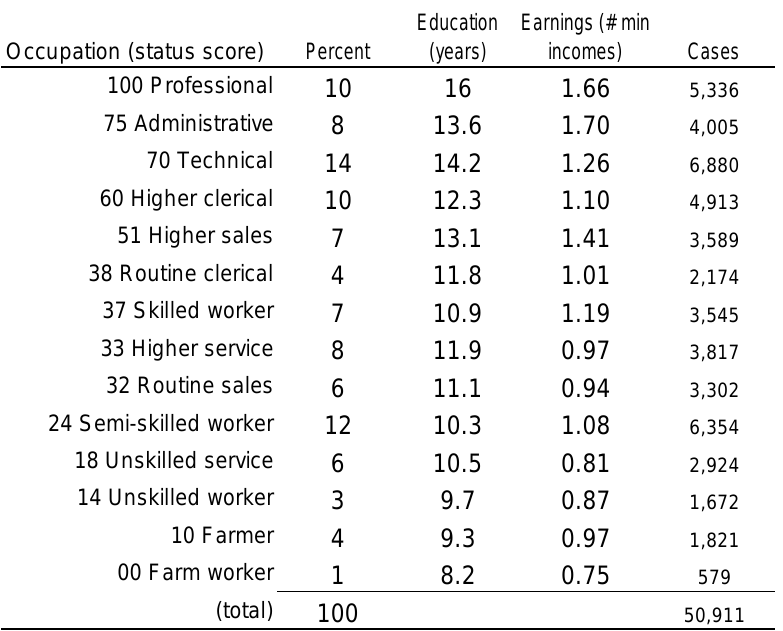
Figure A4. Description: Occupational distribution and mean education (in years) and earnings (number of minimum incomes) by occupation. World Inequality Study version 2.1; 30 nations, 1987–2009.